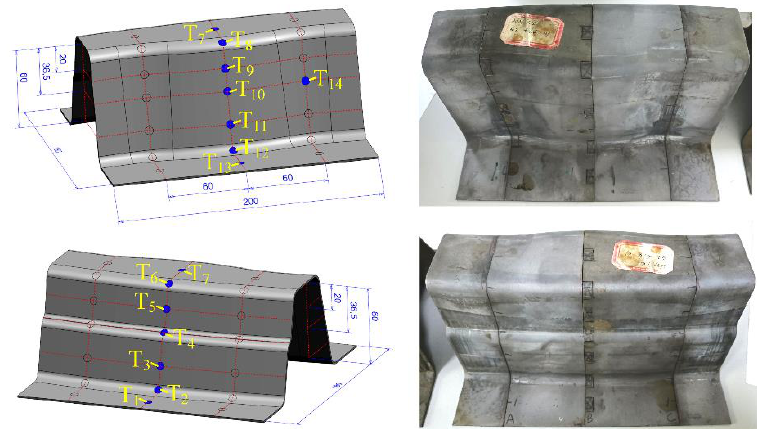
Figure 4. Detecting locations of the similar U-shaped hot stamping samples.